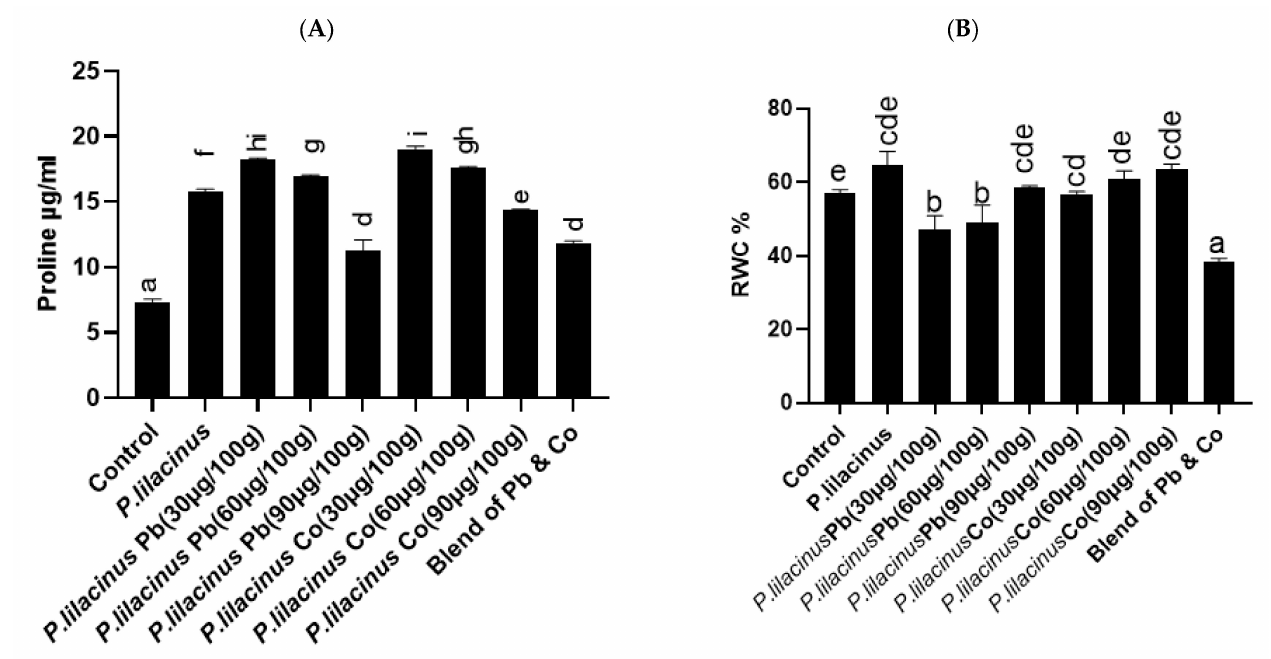
Figure 5. ( A ) Effect of lead and cobalt stresses on proline of S. lycopersicum inoculated with P. lilacinus and without P. lilacinus . Bars represents mean of triplicates with ± SE. Alphabets above the bars are significantly different from one another at p ≤ 0.05. ( B ) Effect of lead and cobalt stresses on RWC of S. lycopersicum inoculated with P. lilacinus and without P. lilacinus . Bars represents mean of triplicates with ± SE. Alphabets above the bars are significantly different from one another at p ≤